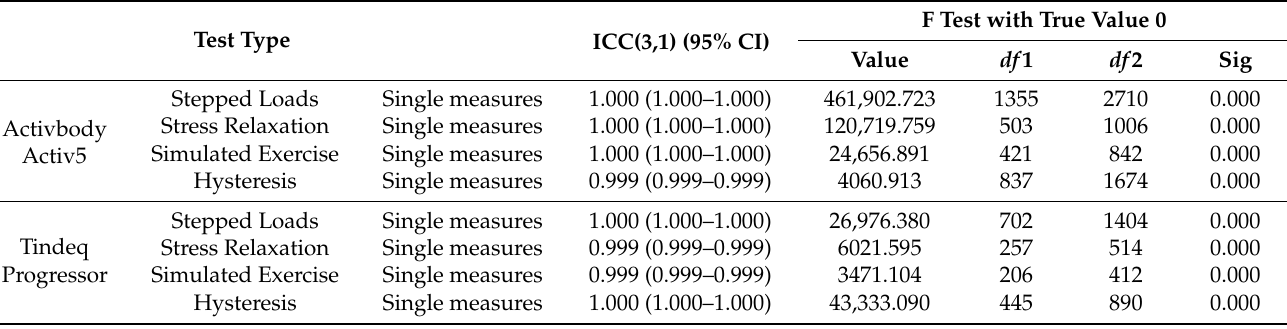
Table 2. Intraclass correlations for test–retest reliability.